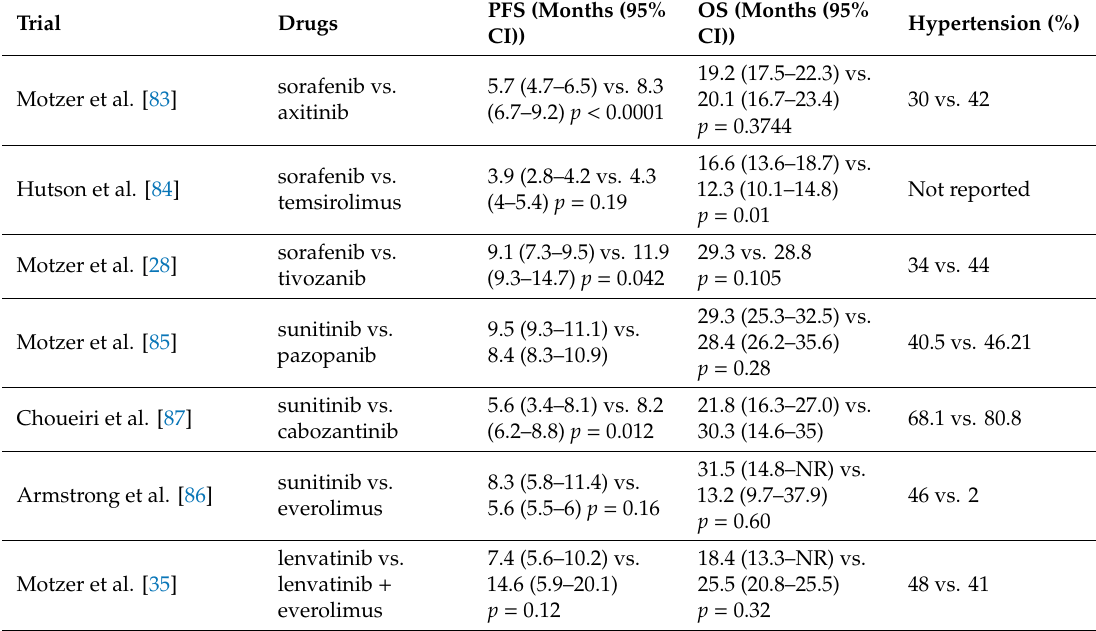
Table 10. Overview of trials that investigated axitinib, sorafenib, sunitinib and lenvatinib with other targeted therapies: special focus on